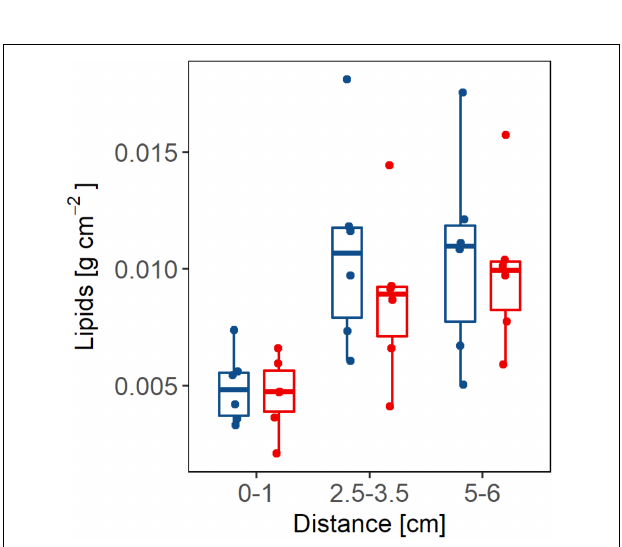
FIGURE 8 | The concentration of lipids (g) per tissue area (cm 2 ) is shown at different distances (cm) from the border of the lesion in branches with partial mortality (red bars) and growth edge in apparently healthy (blue bars)